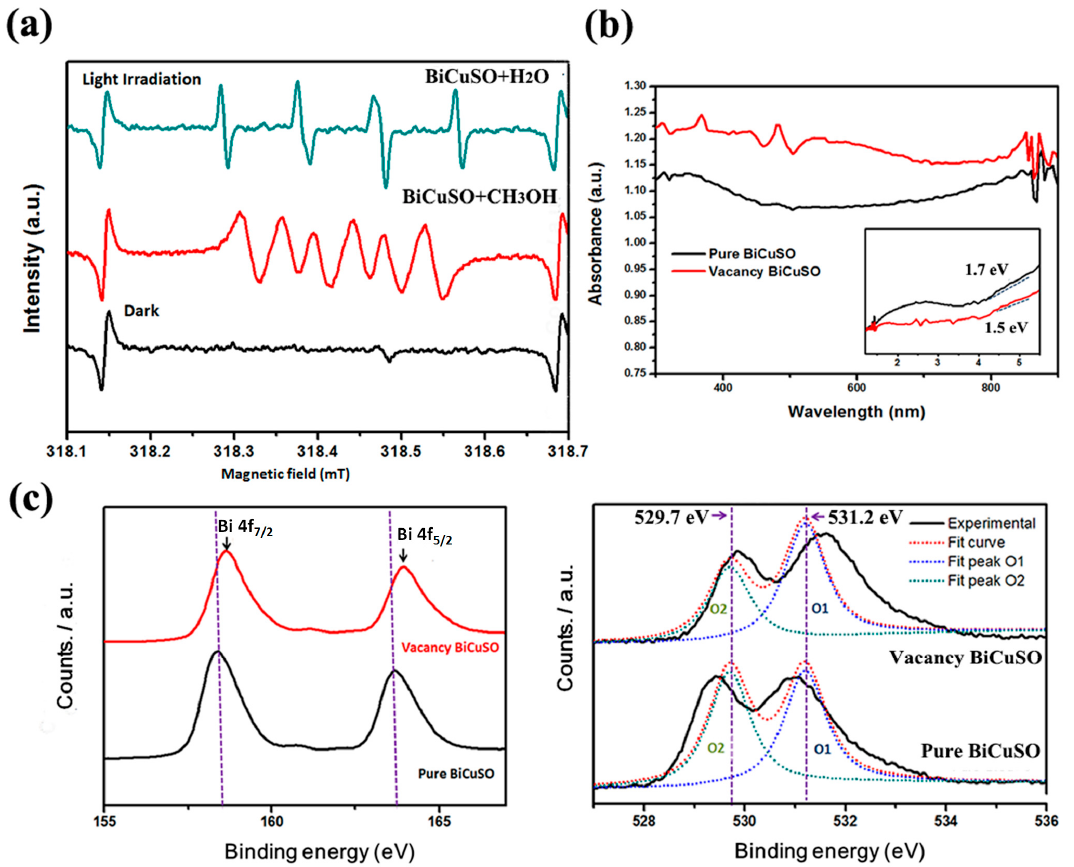
Figure 4. ( a ) ESR signals of the DMPO–trapped •OH (Green) and DMPO-trapped O 2 • − (red) with irradiation and without irradiation. DMPO (50 mM); ( b ) UV–vis diffuse reflectance spectrum of samples; ( c ) XPS spectra of vacant BiCuSO and Pure BiCuSO. Left: Bi 4f spectrum. Right: O 2p